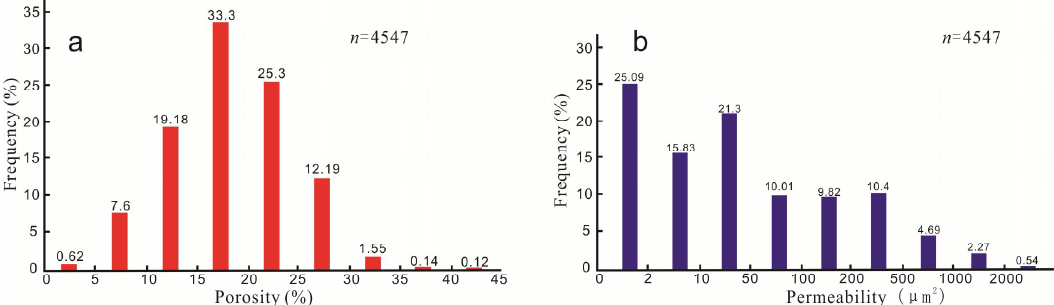
Figure 6. Reservoir properties of sandstones: ( a ) porosity distribution; ( b ) permeability distribution. n is the sample quantity. The micrographs of the casting sheet image and SEM show that the main pore types in the ZVC sandstone reservoirs are intergranular pores, dissolution pores and micro fractures (Figure 7). Intergranular pores are relatively large in size and mostly irregular-polygonal in shape. The size of intergranular pores generally ranges from about 30 μm to about 60 μm, which is mainly controlled by the compaction effect. Dissolution pores are mainly from feldspar and matrix dissolution, with sizes mainly between about 5 μm and about 40 μm. The size of micro fractures is approximately 5 μm in width. Different pore types have different pore structure characteristics (Figure 7).